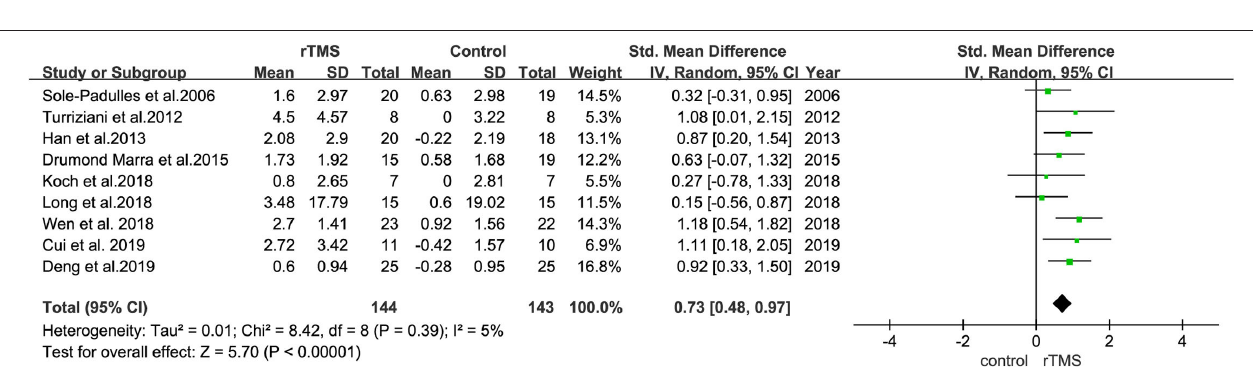
FIGURE 7 | A forest plot showing results of subgroup analyses results for memory outcomes. Mean differences in the effect of rTMS on the memory outcomes in patients with MCI with 95%